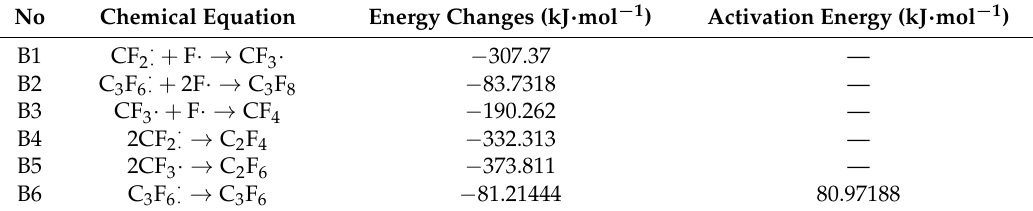
Table 4. Decomposition products and energy change.